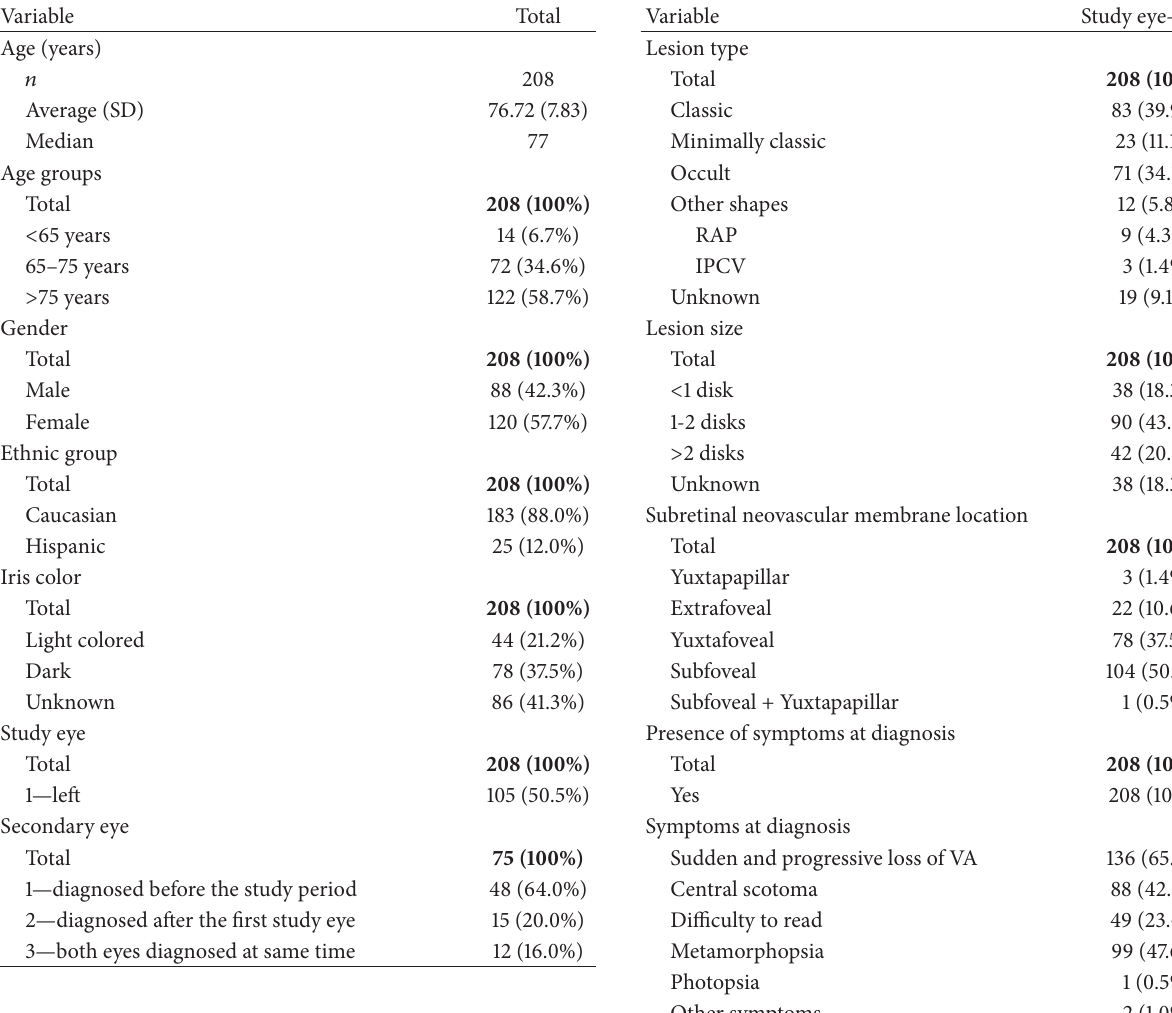
Table 1: Sociodemographic description of patients. Table 2: Description of the lesion and symptoms at